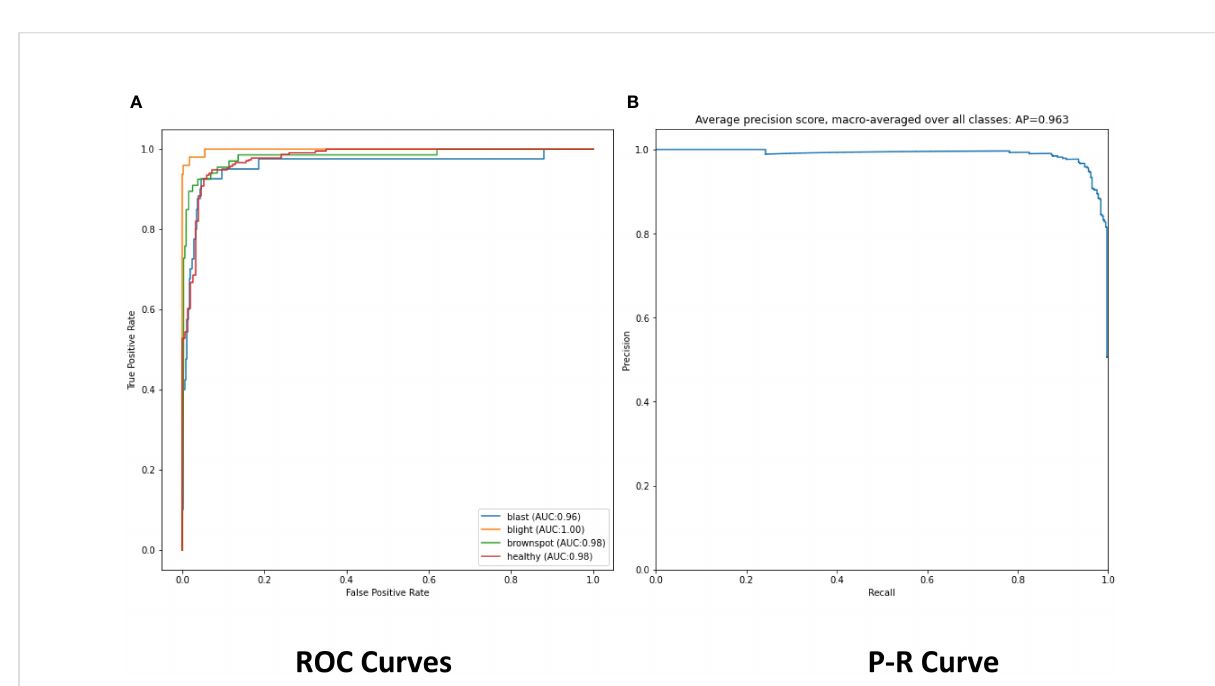
FIGURE 12 (A) The ROC of classi fi cation model. (B) The Precision and Recall of classi fi cation